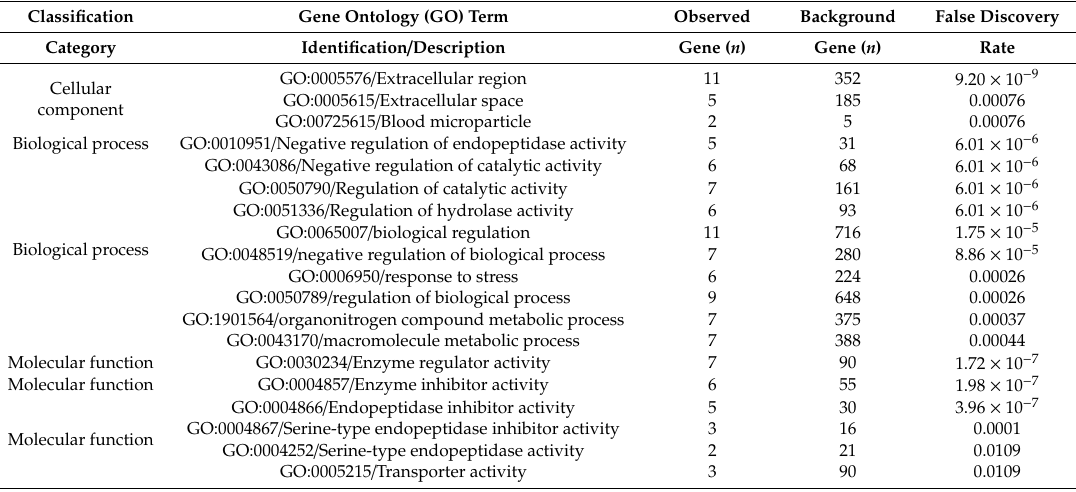
Table 1. Top 10 enriched gene ontology (GO) terms up-regulated in LNA. No significant GO enrichment was found with up-regulated proteins in the SNA